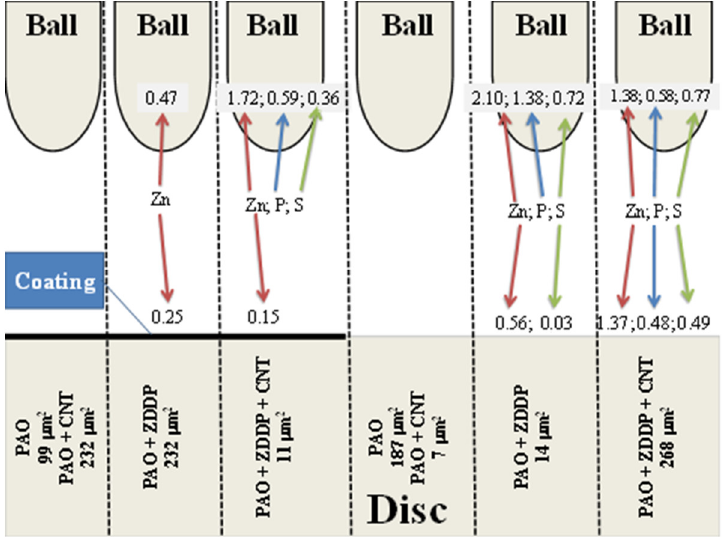
Figure 16. Influence of the coating on the discs and CNTs in the lubricant on the distribution of Zn-, P-, and S-containing products of the ZDDP triboreaction.